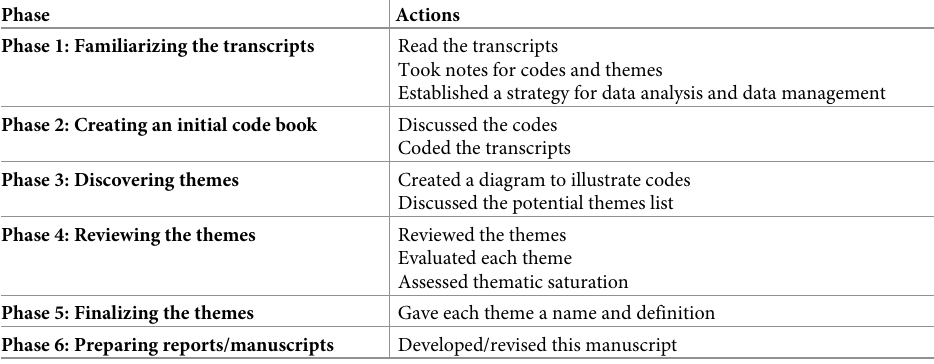
Table 1. Steps of our qualitative data